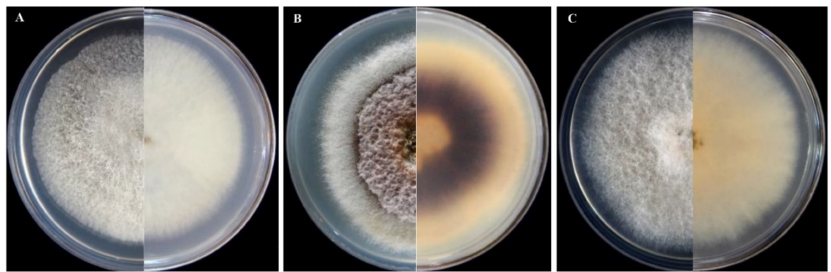
Figure 1. Colony morphology of ( A ) Neocosmospora falciformis (isolate FNol01); ( B ) Fusarium oxysporum f. sp. opuntiarum (isolate OEcg42); and ( C ) Fusarium proliferatum (isolate PEcg29) from succulent plants; front (left) and back (right) side after 5 days incubation on PDA at 25 ◦ C in the